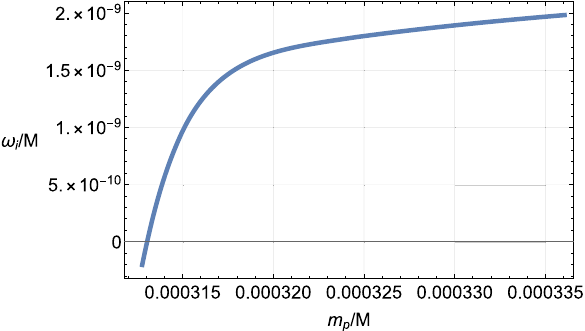
Fig. 4 We plot the dependence of ω i / M in terms of m p / M